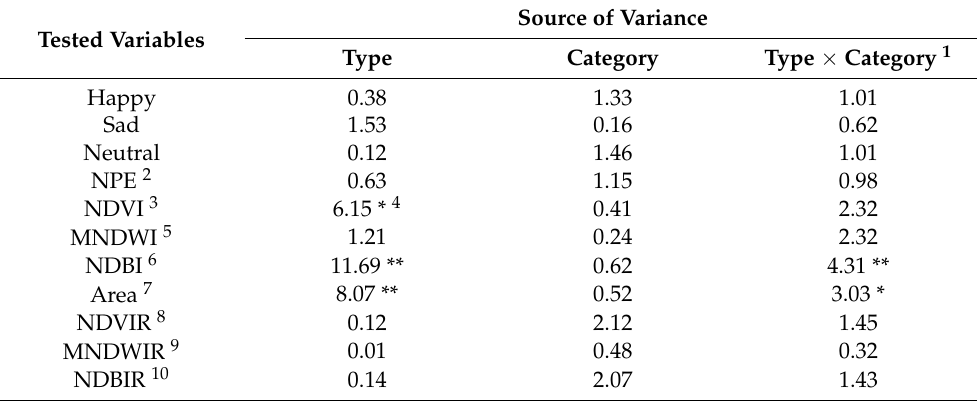
Table 3. F values from ANOVA of community-property effects of product-type (Type: sold vs. on- sale), price category (Category: low, medium, and high), and their interaction (Type × Category) on facial expressions of inhabitants (happy, sad, neutral etc.) and estate landscape metrics. Source of Variance Tested Variables Type Category Type × Category 1 Happy 0.38 1.33 1.01 Sad 1.53 0.16 0.62 Neutral 0.12 1.46 1.01 NPE 2 0.63 1.15 0.98 NDVI 3 6.15 * 4 0.41 2.32 MNDWI 5 1.21 0.24 2.32 NDBI 6 11.69 ** 0.62 4.31 ** Area 7 8.07 ** 0.52 3.03 * NDVIR 8 0.12 2.12 1.45 MNDWIR 9 0.01 0.48 0.32 NDBIR 10 0.14 2.07